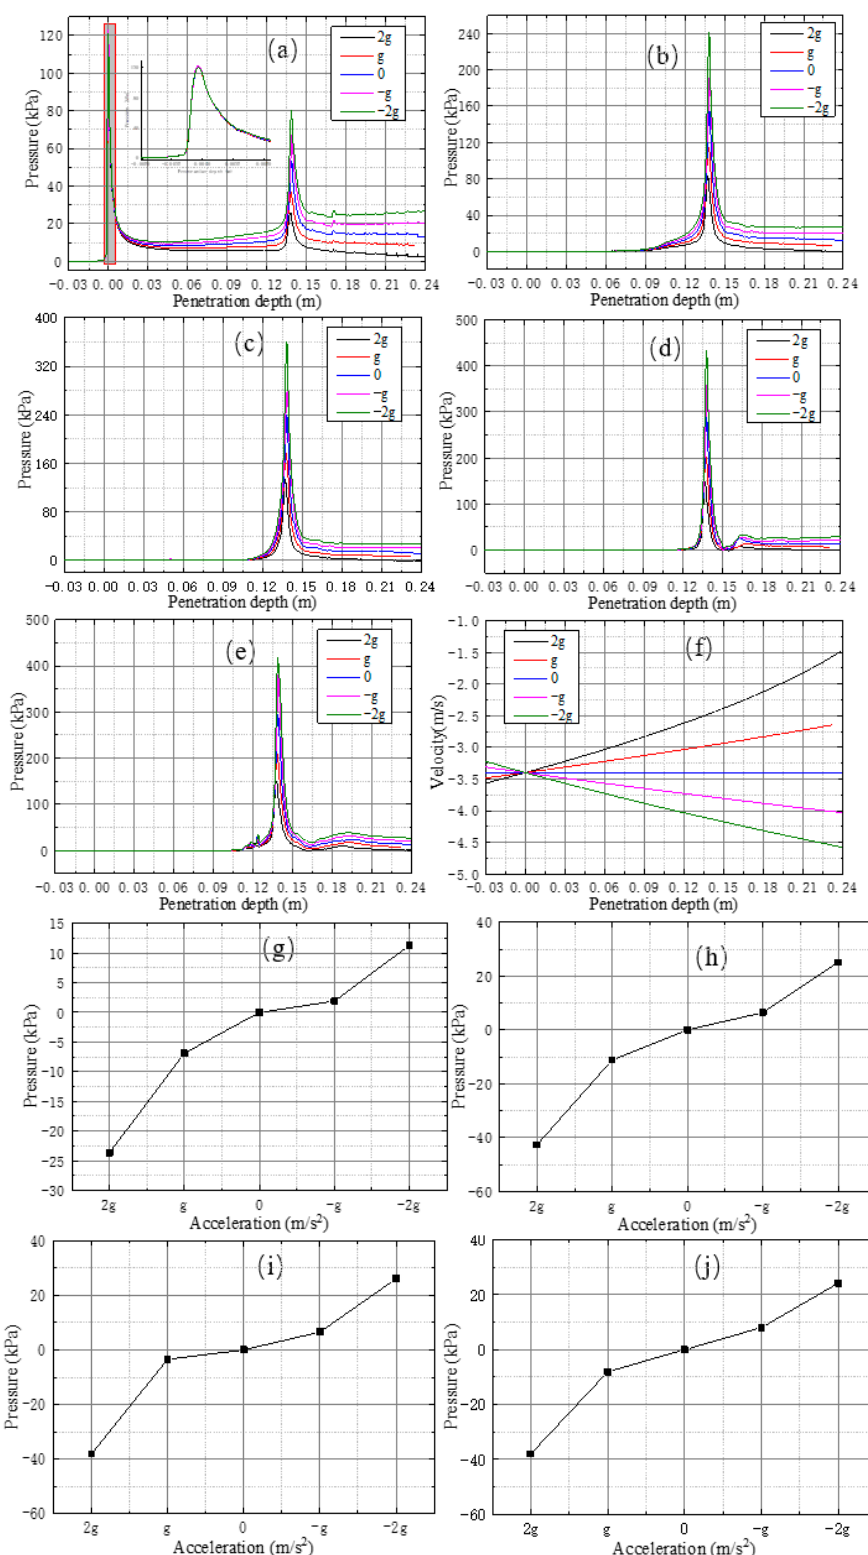
Figure 6. Pressure varying with penetration depth with different constant entry accelerations and pressure peak (after extracting the velocity dependent part) changing with accelerations (( a – e ): pres- sure against penetration depth at five monitoring points for different entry accelerations; ( f ) velocity against penetration depth; ( g – j ): peak pressures of monitoring points p2~p5 varying with corre- sponding accelerations).